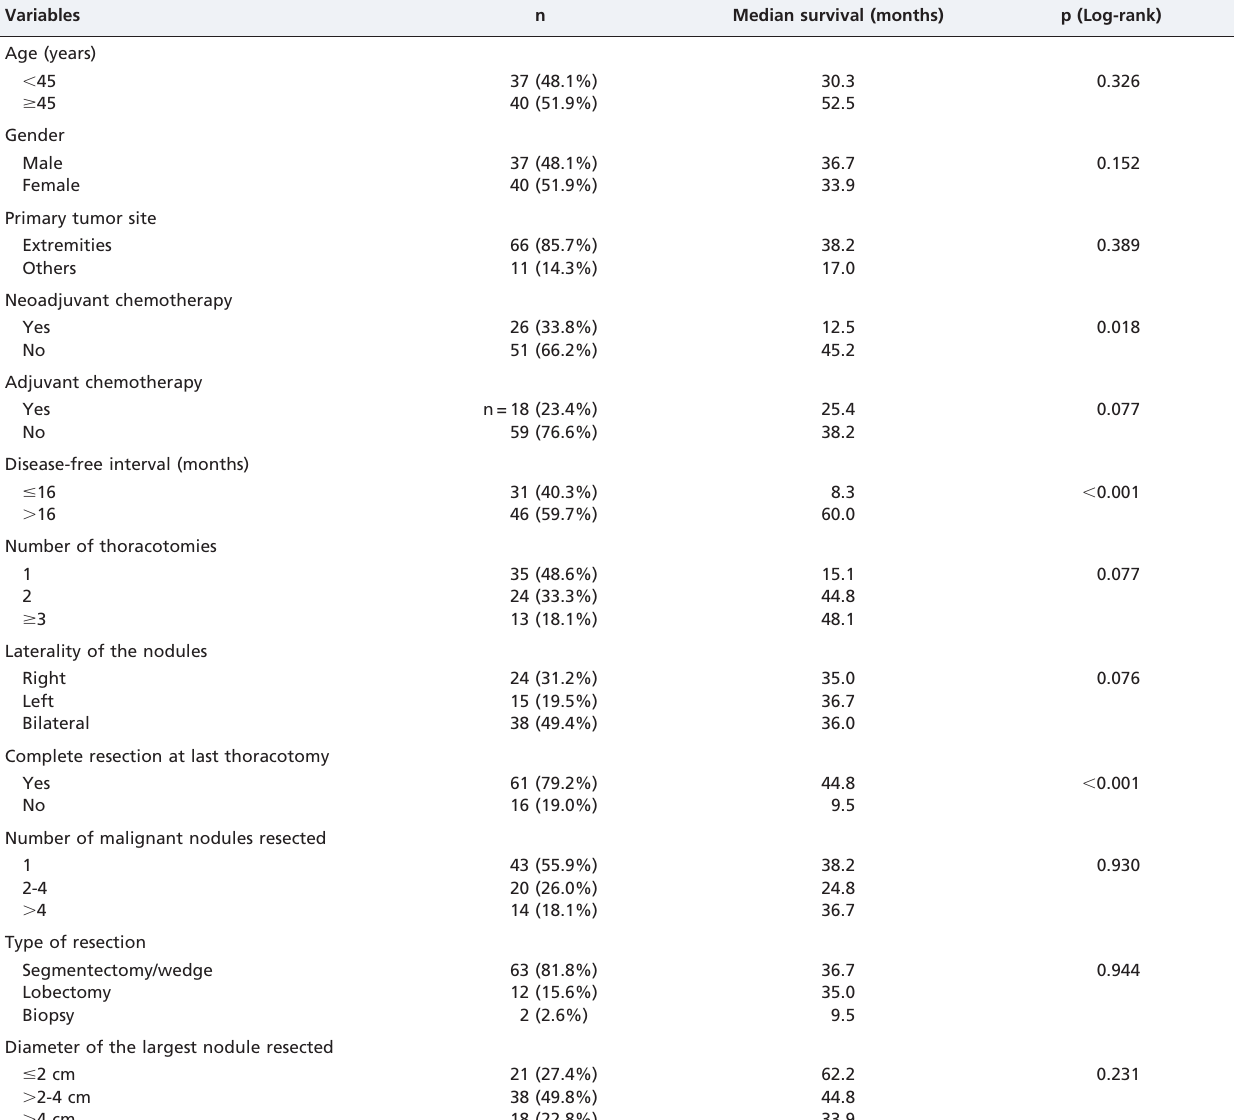
Table 3 - Univariate analyses and characteristics of the 77 patients submitted to pulmonary metastasectomy.